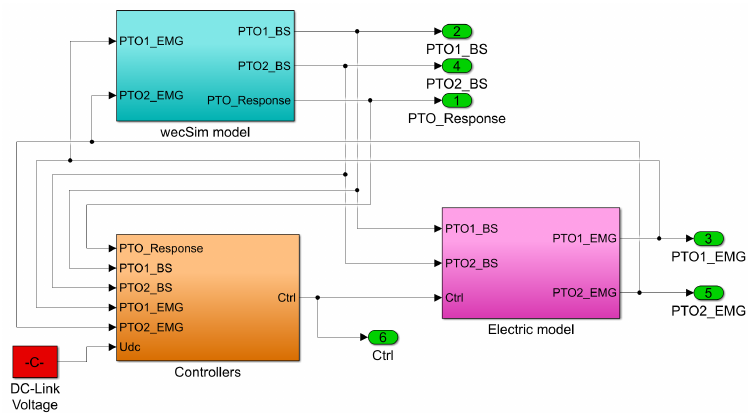
Figure 6. Components of the SM_PLANT